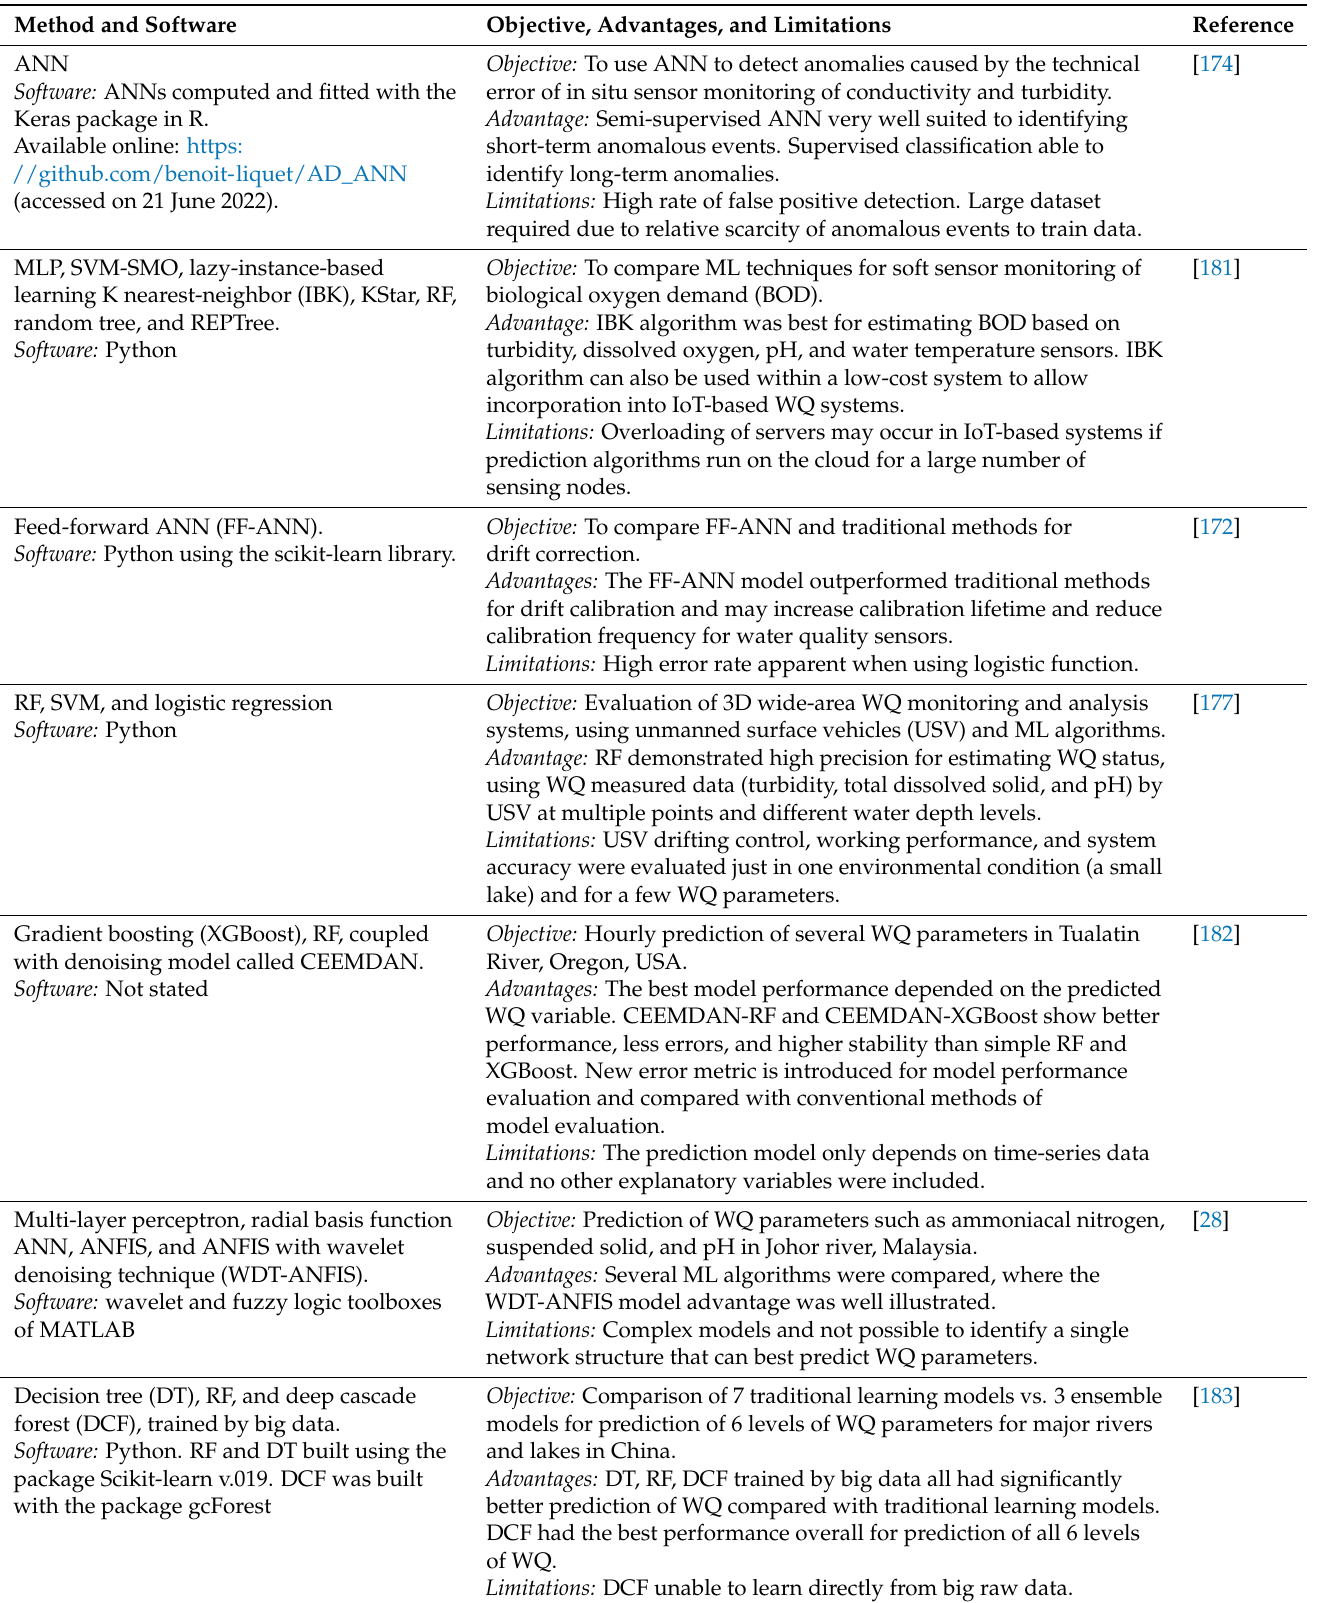
Table 4. Selected GeoAI applications in monitoring and spatio-temporal prediction of water